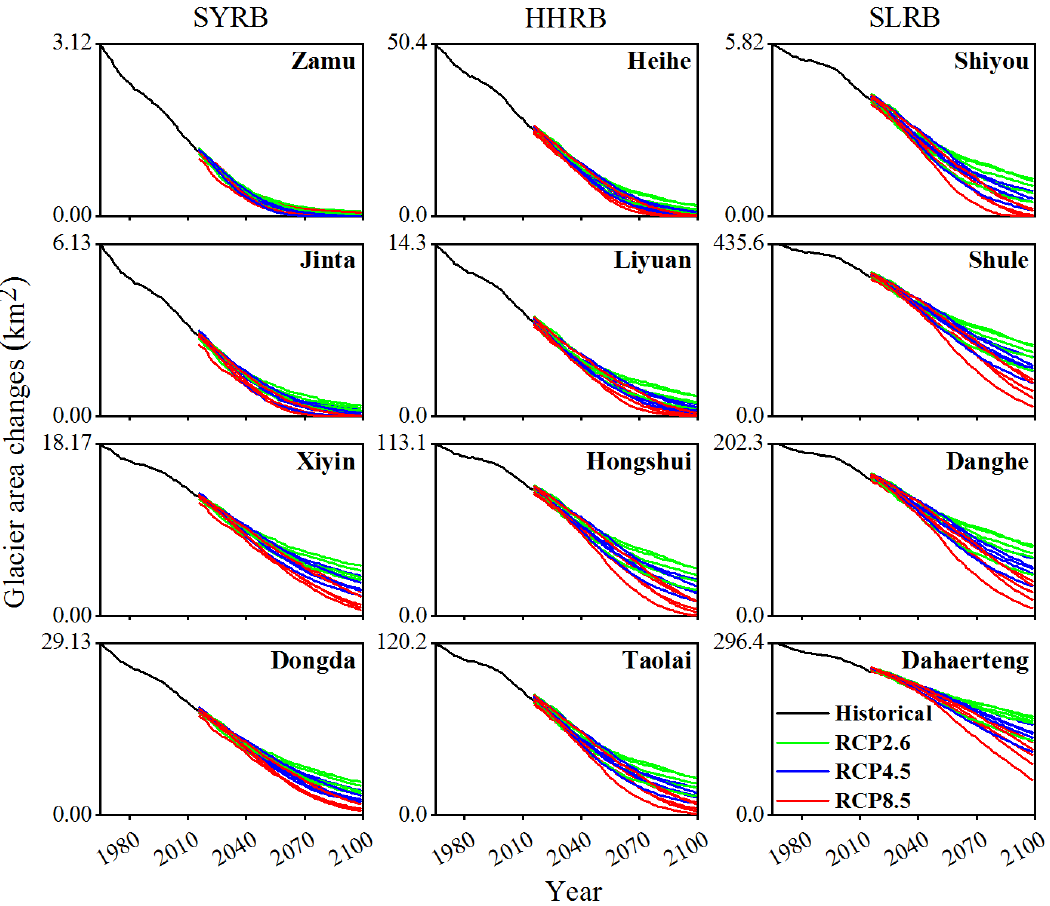
Figure 6. The area changes of total glaciers in each subbasin from 1965~2100. Each column shows four subbasins from each of the three main basins (SYRB, HHRB and SLRB). In each subplot, the black line represents the historical changes in glacier area from 1965~2016 and the colored lines represent the future changes in glacier area under different GCMs from 2016~2099. For the latter, the green, blue and red lines show the changes under RCP2.6, RCP4.5 and RCP8.5, respectively.